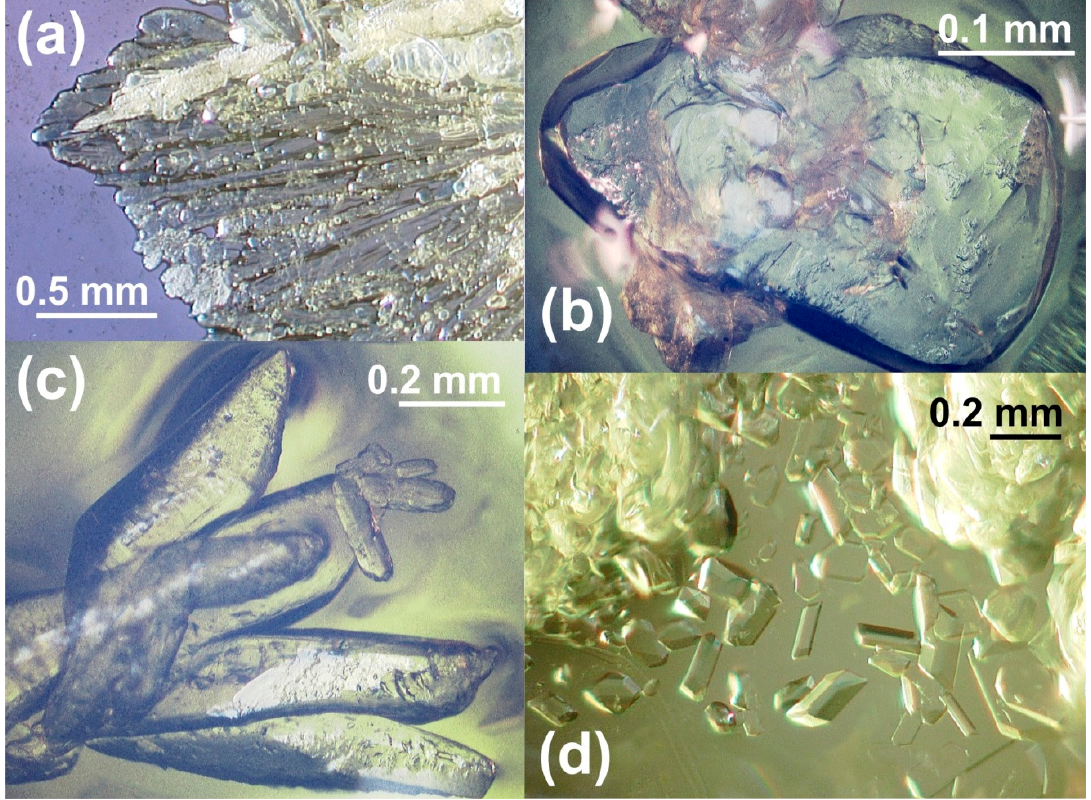
Figure 1. Crystals of 1 – 3 ( a – c ) and 6 ( d ) formed in the described synthetic experiments.